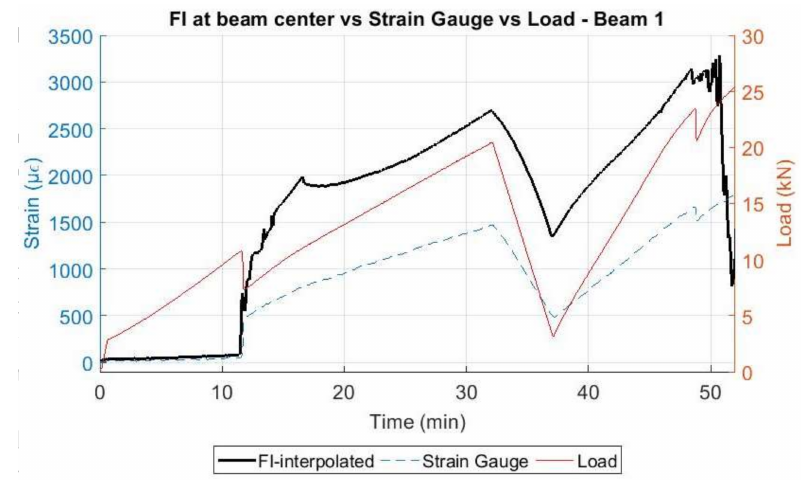
Figure 24. Comparison of DOFS with strain gauge and the applied load—Beam 1.